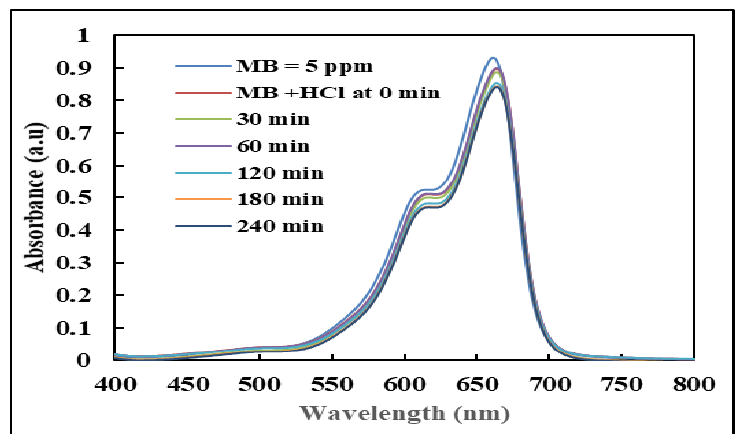
Figure 4: UV-Vis. absorption spectra of MB (5ppm) with pH =3 catalysis by ZnO/epoxy nanocomposite (2 wt. %).